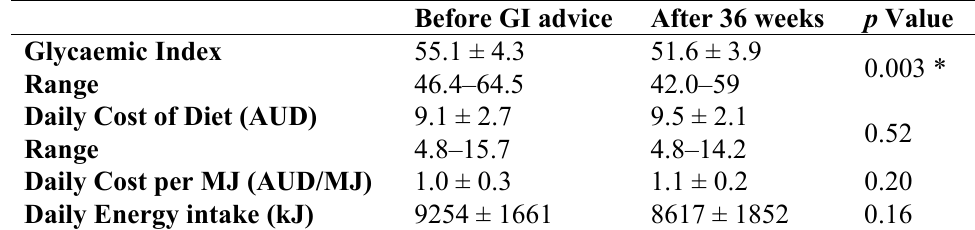
Table 2. Glycaemic index (GI), average daily cost (AUD), cost per MJ (AUD/MJ) and daily energy intake (kJ) before initiating a low GI diet and at 36 weeks gestation.